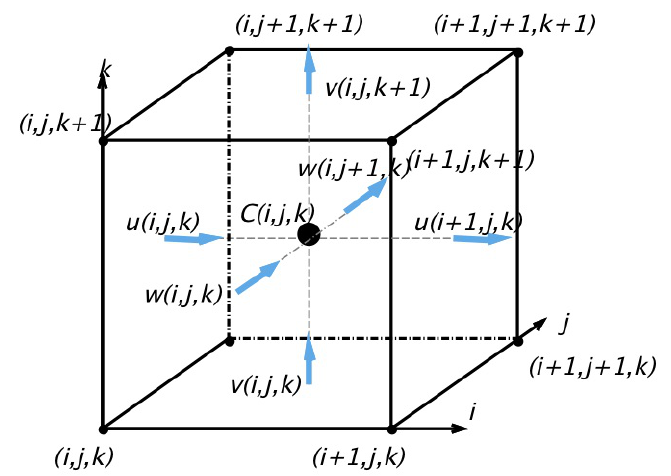
Figure 1. Diagram of the Arakawa C-grid, in which the velocity components u, v, and w are staggered by half a grid spacing. Scalars such as salinity S or temperature are located in the